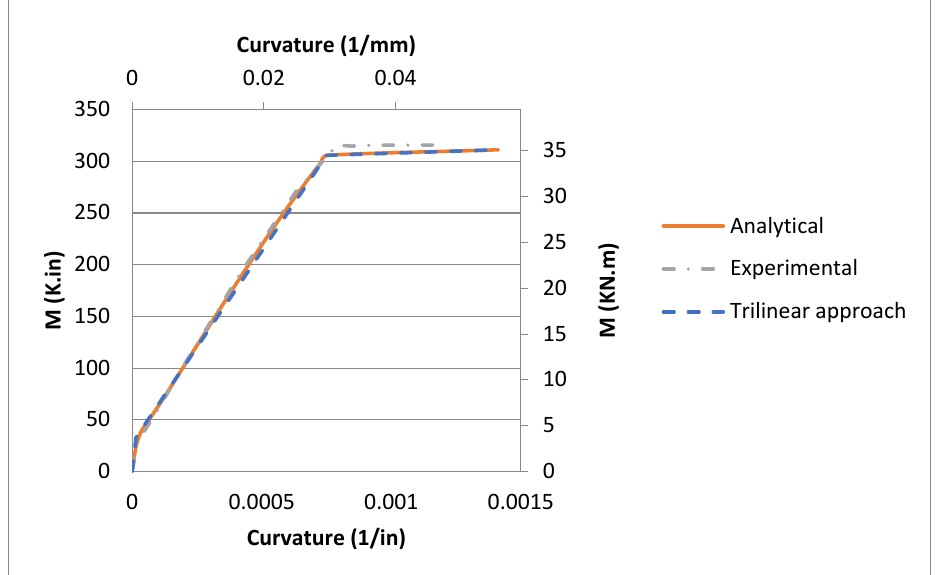
Figure 24. Almusallam (1997) [19] moment vs. curvature analytical graphs.